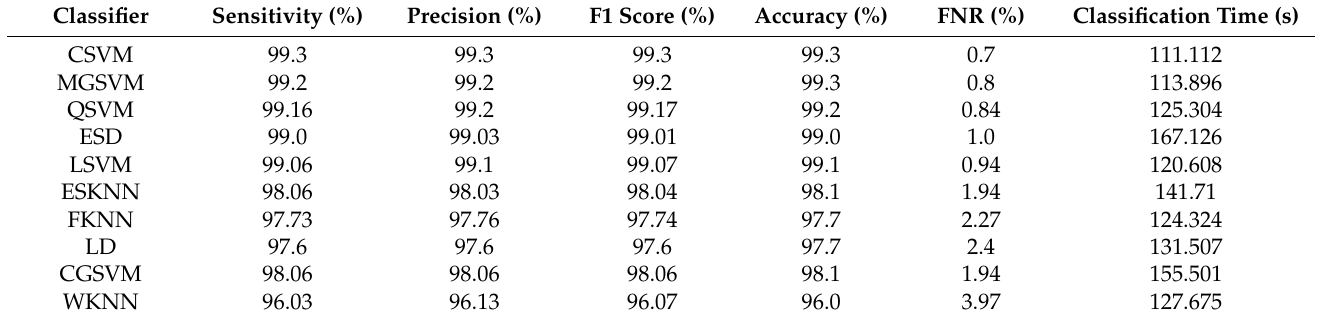
Table 3. Classification results of DarkNet53 using ultrasound images, where the training/testing ratio is 70:30.